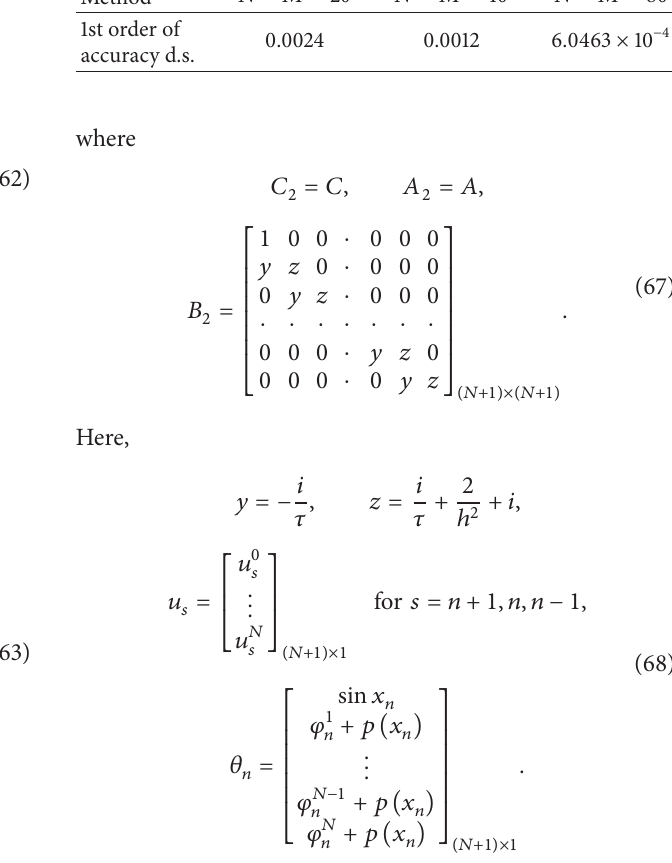
Table 1: Error analysis for the exact solution 𝑢(𝑡,𝑥) .